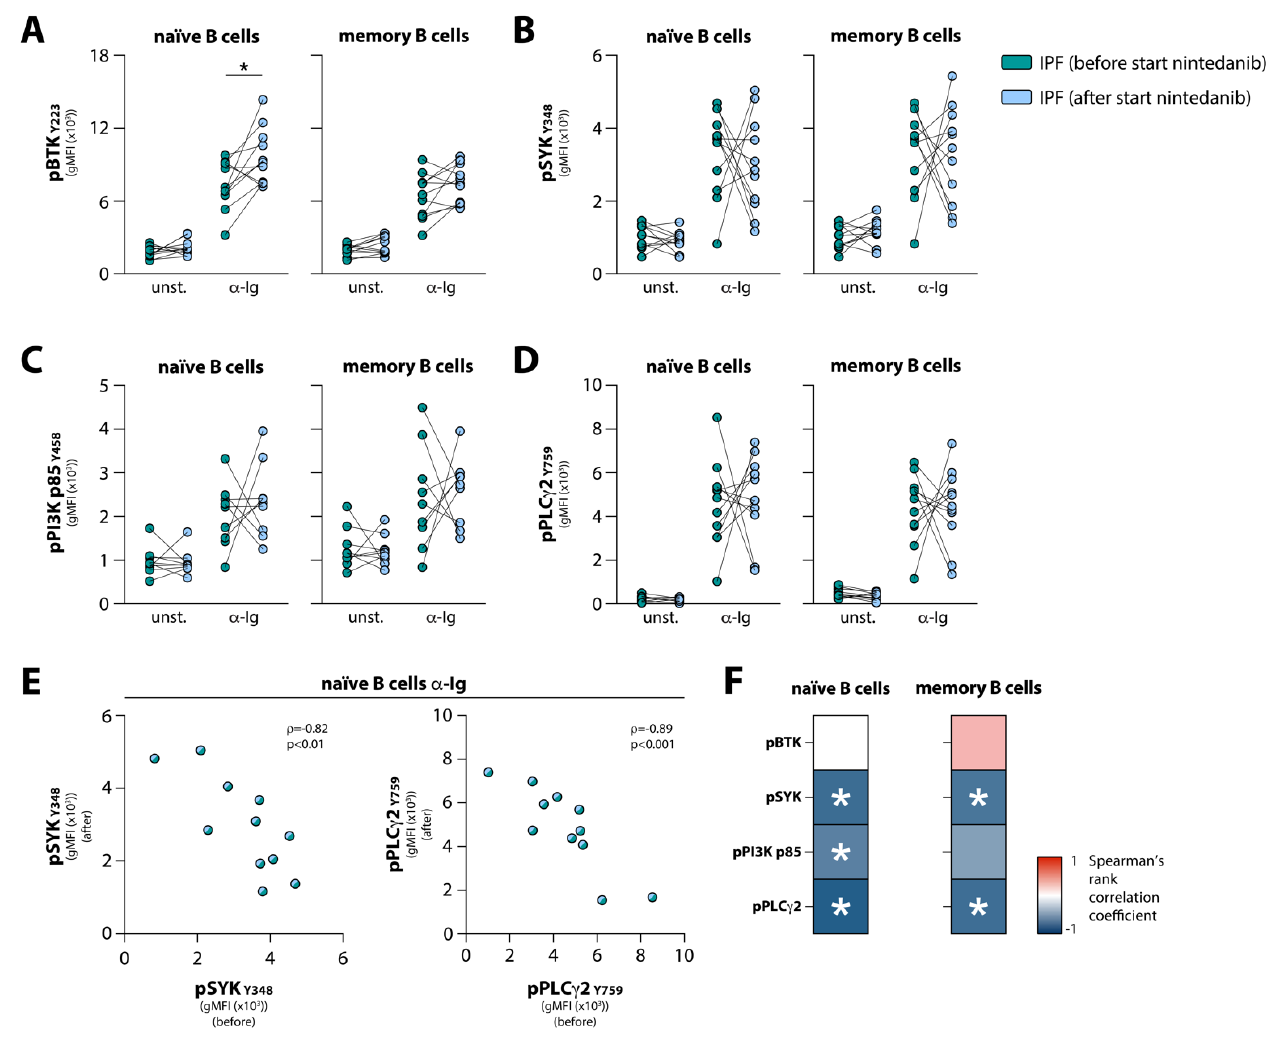
Figure 4. Phosphoflow analysis of BCR downstream signaling in nintedanib-treated IPF patients’ peripheral blood B cells (cohort 2). ( A – D ) Phosphorylation levels in unstimulated (unst.) conditions and after α -Ig stimulation for ( A ) pBTK Y223 , ( B ) pSYK Y348 , ( C ) pPI3K p85 Y458 , and ( D ) pPLC γ 2 Y759 in naïve (CD3 − CD19 + CD38 lo CD27 − IgD + ) and memory (CD3 − CD19 + CD38 lo CD27 + ) B cells from IPF patients before and after the start of nintedanib treatment. ( E , F ) Spearman’s rank correlation analysis of the phosphorylation levels for ( E ) pSYK ( left ) and pPLC γ 2 ( right ) in naïve B cells following BCR stimulation, before versus after the start of nintedanib treatment. ( F ) Spearman’s rank correlation matrix for phosphorylation of BCR signalosome molecules before and after the start of nintedanib treatment. Subjects are indicated by individual data points. * p < 0.05 in ( A ) by a paired two-tailed Student’s t